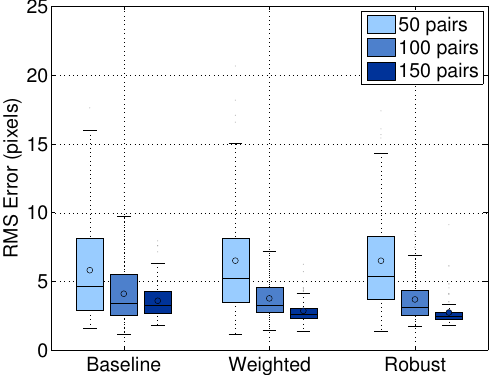
Figure 7. Comparison of our baseline approach with the weighted and robust extensions: the results were computed as a function of the number of image/scan pairs evaluated using 10-fold cross-validation. The errors were estimated by measuring the RMS distance with the ground truth. Circles and horizontal lines in boxes indicate the mean values and the median values of the